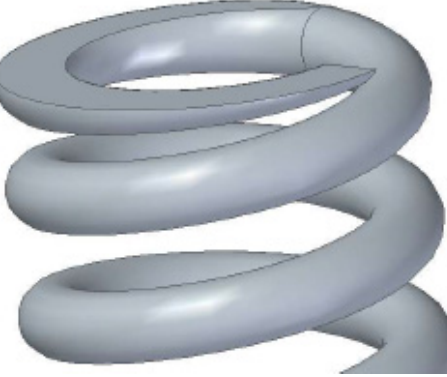
Figure 7. The end of squared and ground helical spring.